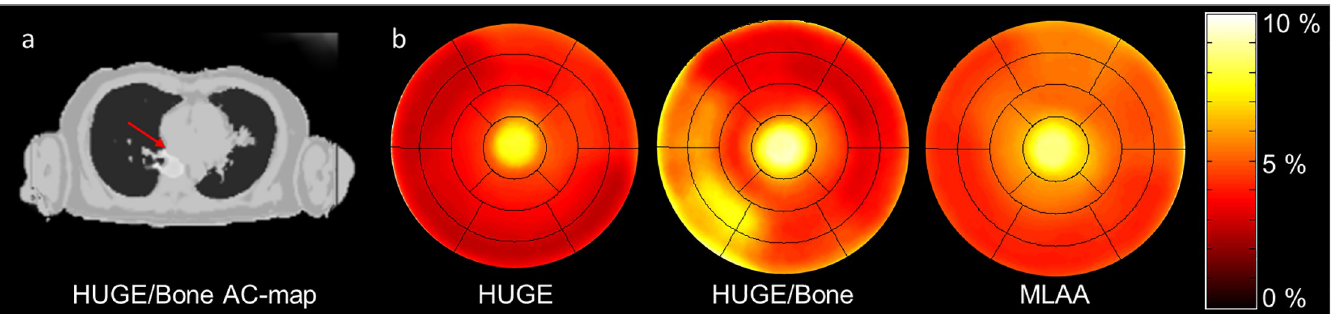
Fig 7. Patient example with bone artifact. Patient example with bone artefact (red arrow) in the HUGE + bone AC-map (a). Corresponding difference polar plots of HUGE only, HUGE + bone and MLAA corrected PET data in comparison to standard Dixon-VIBE AC (b). Note that HUGE only and MLAA corrected PET data show a slight decrease in relative difference inferior-medial, whereas, in HUGE and bone corrected data (middle polar plot) an increase in relative difference in segments 2–3 and 8–9 is observable.